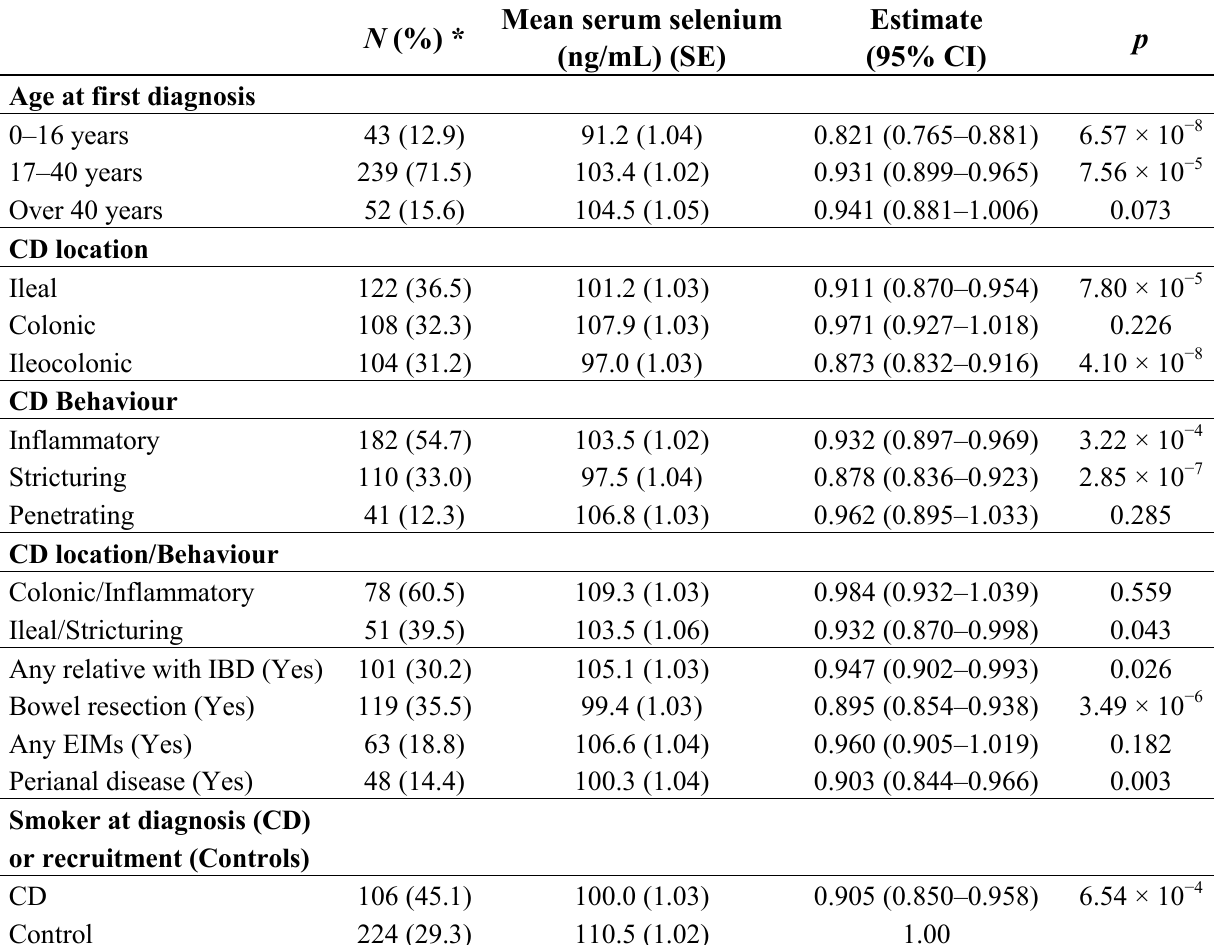
Table 3. Frequency and mean serum selenium level with estimate by CD and